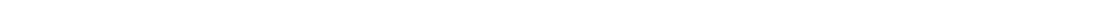
Fig. 1 Global functional analysis of the Zbtb16 locus by ATAC-seq and CRISPR/Cas9. a ATAC-seq pro fi les of the Zbtb16 locus in CD4SP and NKT thymocytes, and in CLP and ILCP bone marrow cells. Shaded areas highlight clusters of peaks selected for CRISPR/Cas9 deletion based on differences in pro fi les between NKT vs CD4SP or ILCP vs CLP. Data are representative of two to three biological replicates. b Top row Hindlimb autopods of mice carrying different genomic deletions as indicated; extra digits or homeotic transformations of digits are labeled by an asterix and the frequency of mice with digit abnormalities is shown in the summary plot. Second row FACS analysis of PLZF and PD1 expression by BM Lin - IL7R α + α 4 β 7 + cells from mice carrying indicated CRISPR/Cas9 deletions; absolute numbers (mean ± S.E.M.) of ILCP (PD1 + ) and PLZF-expressing ILCP (PLZF + PD1 + ) are indicated on top of the FACS panels; the percentage of PLZF expression by ILCP is compiled in the summary scatter plot. Bottom two rows FACS analysis of CD1d- α GalCer tetramer and PLZF staining among total thymocytes and splenocytes of mice carrying indicated deletions; absolute numbers (mean ± S.E.M.) of NKT (CD1d- α GC Tetramer + PLZF + ) and percentages are indicated on top of the FACS panels and in the summary scatter plots respectively. Summary data are pooled from 15 separate experiments, with a total of 4 – 42 mice in each group. Statistical analysis was performed using one-way ANOVA for multiple comparisons to WT littermate controls (LM). * P < 0.05, ** P < 0.01, *** P < 0.001, **** P <